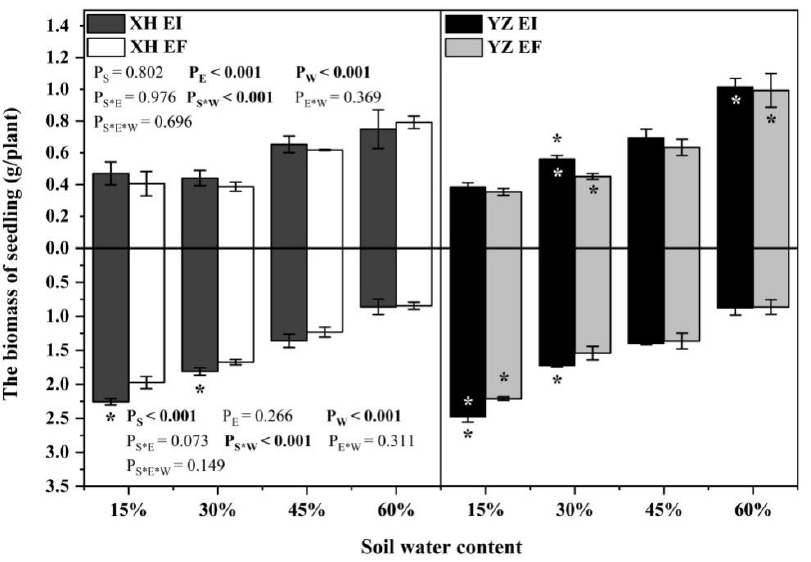
Figure 1. The biomass of A.inebrians seedlings shoots and roots from XH(W) and YZ(D) seeds under various soil water content (g/plant). Upwards and downwards bars represent the value of shoot and root part, respectively. The asterisk (*) above/below error bars means significant difference ( p < 0.05) between EI and EF under the same soil water content. White/black * in the black/gray bars indicates significant difference ( p < 0.05) between Xiahe and Yuzhong maternal habitat type of EF/EI grasses.